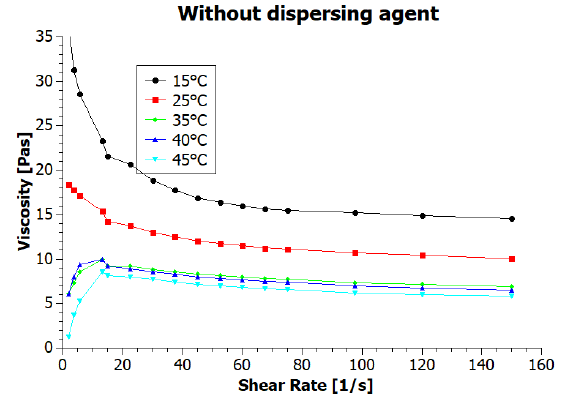
Figure 3. Viscosity curves of graphene ink without dispersing agent at various temperatures.